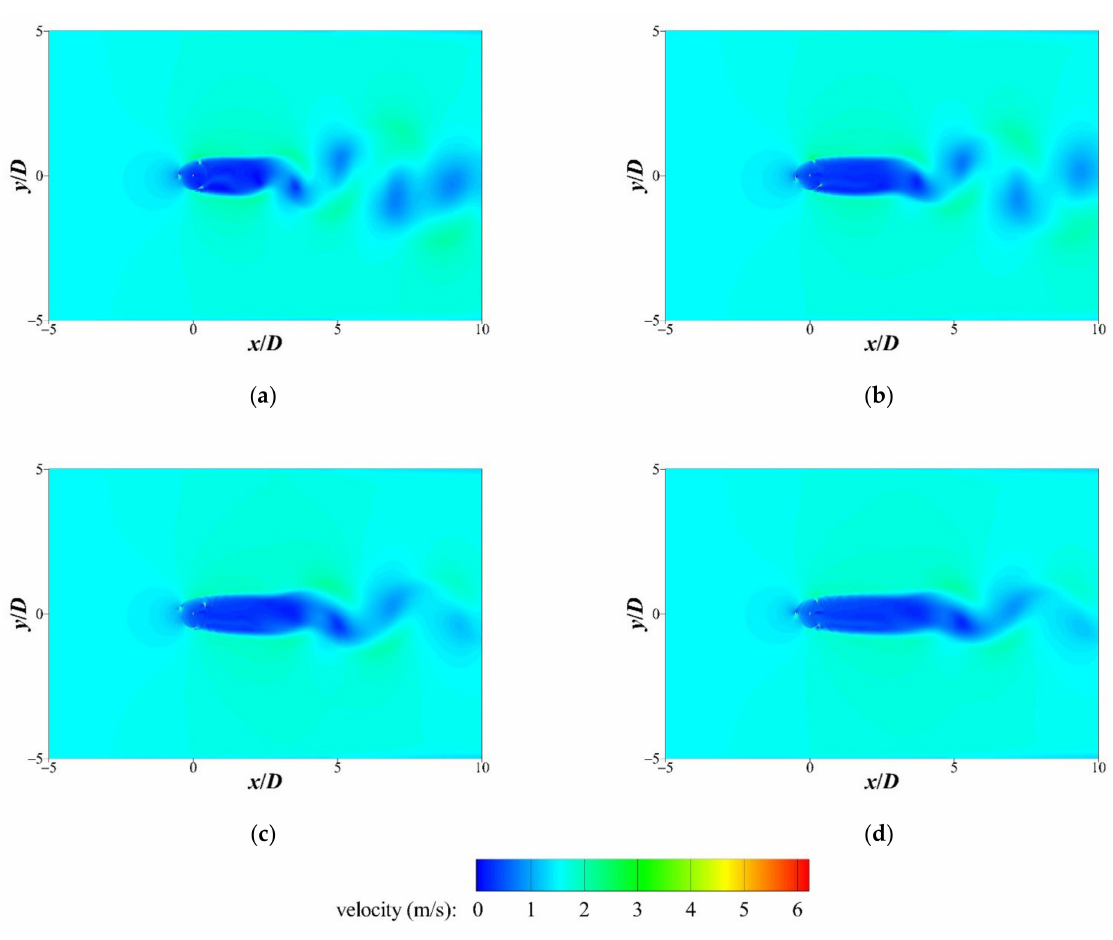
Figure 10. Flow velocity contours of a stand-alone turbine under four different loads: ( a ) L = 2, ( b ) L = 6, ( c ) L = 10, and ( d ) L =